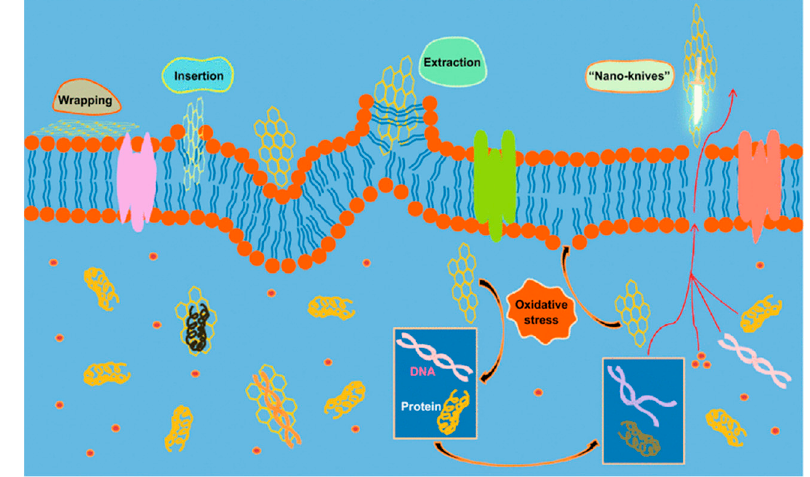
Figure 2. Mechanisms of the antimicrobial activities of graphene-based materials. Reprinted with permission from [57]. Copyright American Chemical Society, 2016.